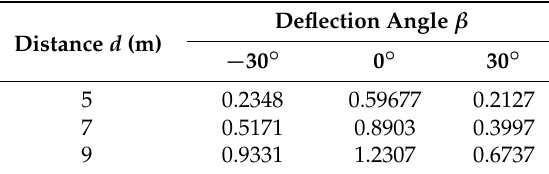
Table 1. Fixed-angle fluctuation analysis.